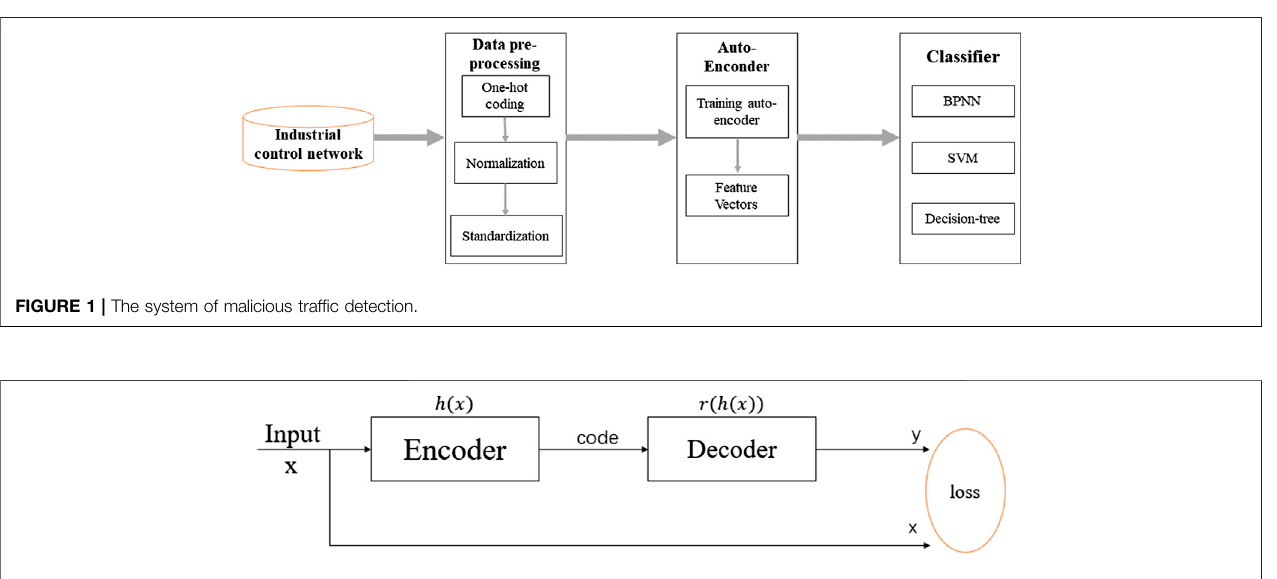
FIGURE 2 | Autoencoder